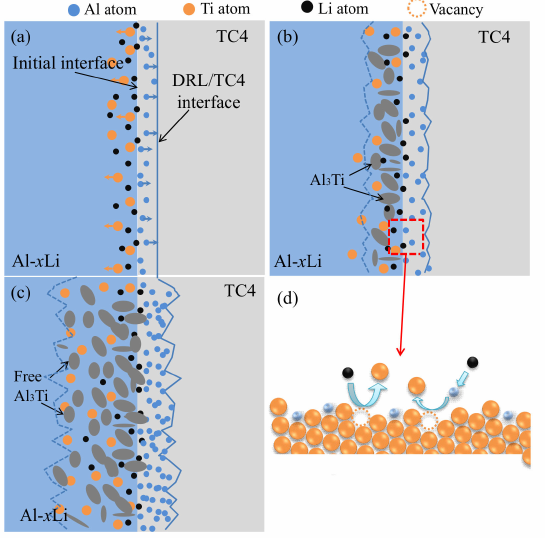
Figure 8. Conceptual model of structural evolution in Al–xLi/TC4 liquid–solid interface diffusion layer. ( a ) Formation of primary Al 3 Ti laye ( b ) Growth of Al 3 Ti layer ( c ) Granular Al 3 Ti particles separated from the Al 3 Ti layer ( d ) Atomic diffusion